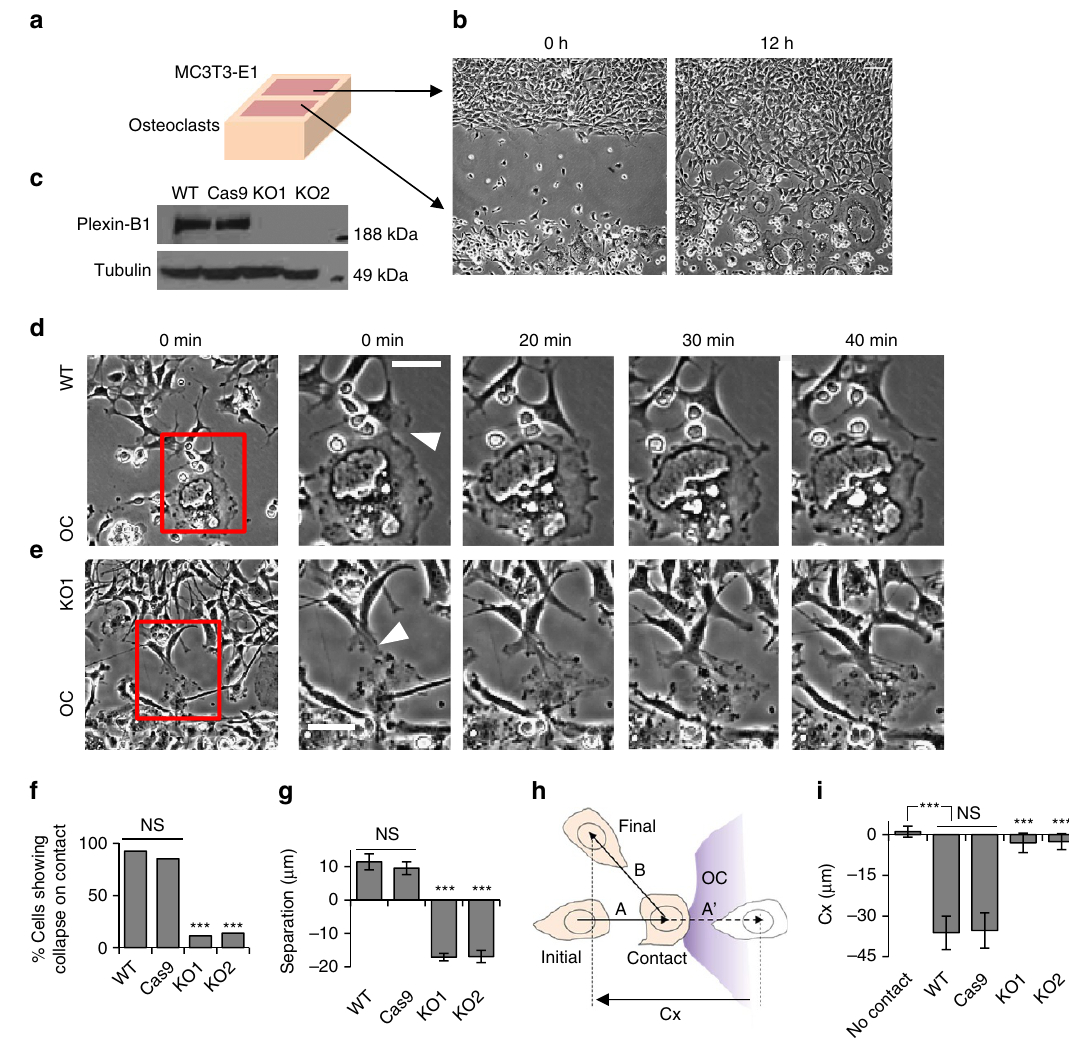
Figure 1 | Plexin-B1 mediates CIL between osteoclasts and osteoblastic cells. ( a ) Cartoon representation of culture inserts used for co-culture of osteoclasts with primary osteoblasts or MC3T3-E1 cells. ( b ) Phase-contrast images acquired immediately and 12h after lifting the culture insert showing migration of MC3T3-E1 cells towards osteoclasts. Scale bar, 50 m m. ( c ) Comparison of Plexin-B1 expression in wild-type (WT), Cas9, KO1 and KO2 MC3T3-E1 cells. Tubulin was used as a loading control. ( d , e ) Phase-contrast images showing a MC3T3-E1 WT ( d ) or MC3T3-E1 KO1 ( e ) cell in contact with an osteoclast (OC). Insets are magnified to show changes in cell morphology and migration between time of contact and 20, 30 and 40min after contact. Scale bar, 50 m m. White triangles point to the site of cell–cell contact. ( f ) Percentage of WT, Cas9, KO1 and KO2 MC3T3-E1 cells that show collapse of protrusions within 30min after contact with an osteoclast. n ¼ 209–301. ( g ) Separation between MC3T3-E1 cells and osteoclasts 40min after contact. n ¼ 41–45. ( h ) Cartoon describing Cx. ( i ) Cx values for WTcells, Cas9, KO1 and KO2 MC3T3-E1 cells without (WTonly) and after contact with osteoclasts. n ¼ 20. For g , i , means ± s.e.m. are shown. *** P o 0.001 and * P o 0.05, NS, not significant, Student’s t